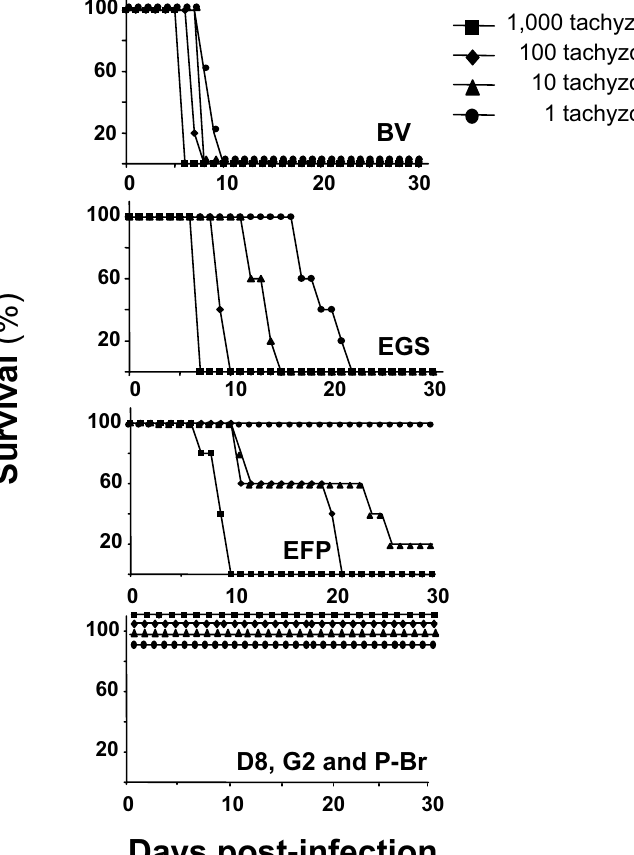
Fig. 1 – Survival of BALB/c mice infected with intra-peritoneal injections of 1, 10, 10 2 , or 10 3 tachyzoites from highly virulent (BV), virulent (EGS), intermediate virulent (EFP) or avirulent (D8, G2 and P-Br) Type I/III strains of T. gondii . Data from one representative experiment. Experiment was repeated two times with similar